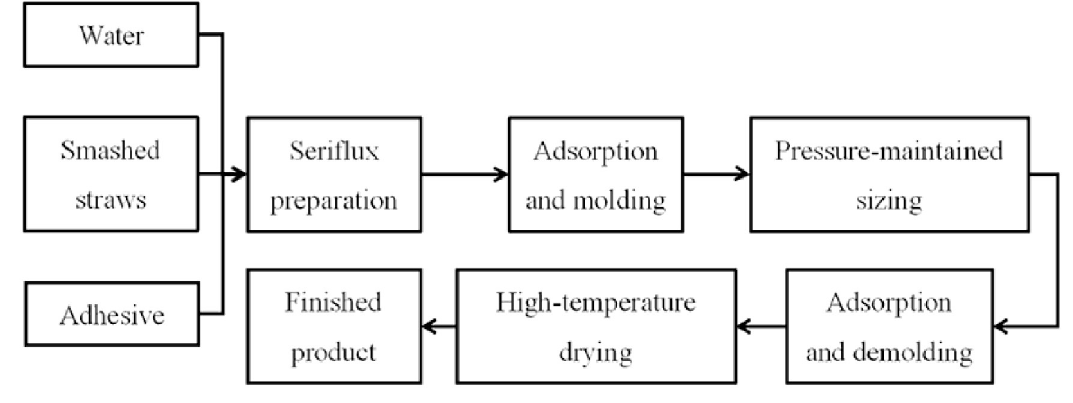
Fig 4. Preparation processing of rice straw bowl